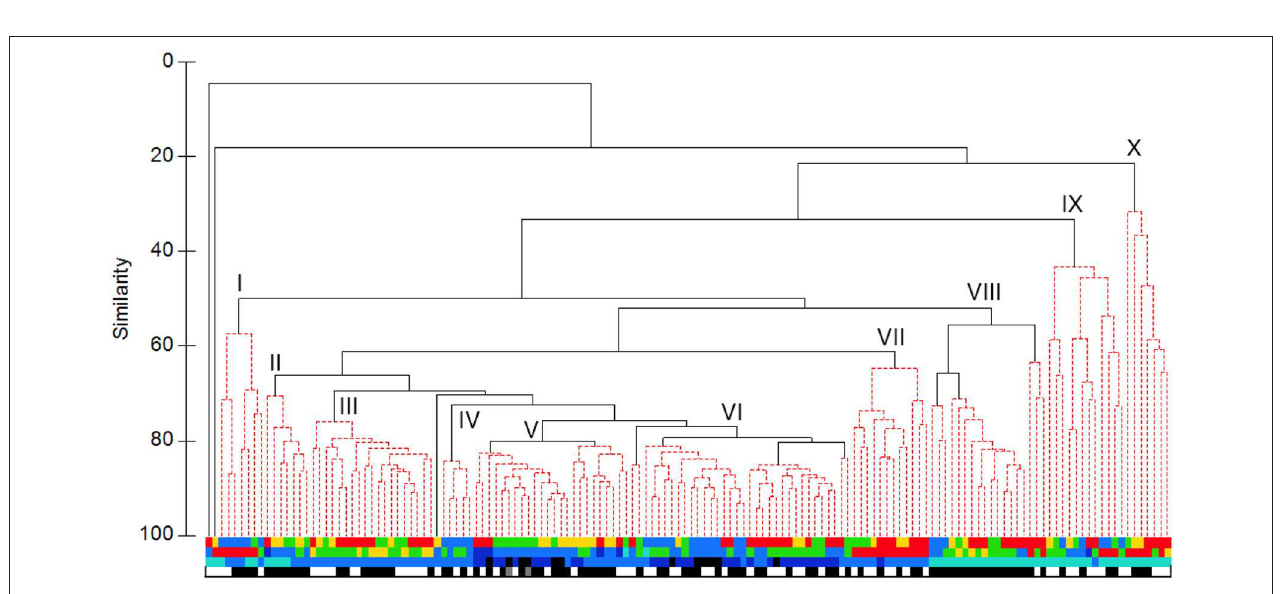
FIGURE 6 | UPGMA cluster of sets based on catch weight: Colour coding as in Figure 5 . Roman numerals identify the major clusters described in the text.